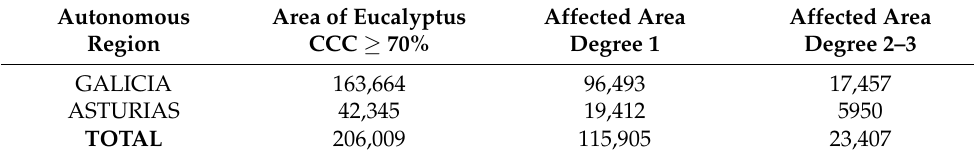
Table 1. Areas of eucalyptus and the affected part according to the degree of defoliation (2013). Autonomous Area of Eucalyptus Affected Area Affected Area Region CCC ≥ 70% Degree 1 Degree 2–3 GALICIA 163,664 96,493 17,457 ASTURIAS 42,345 19,412 5950 TOTAL 206,009 115,905